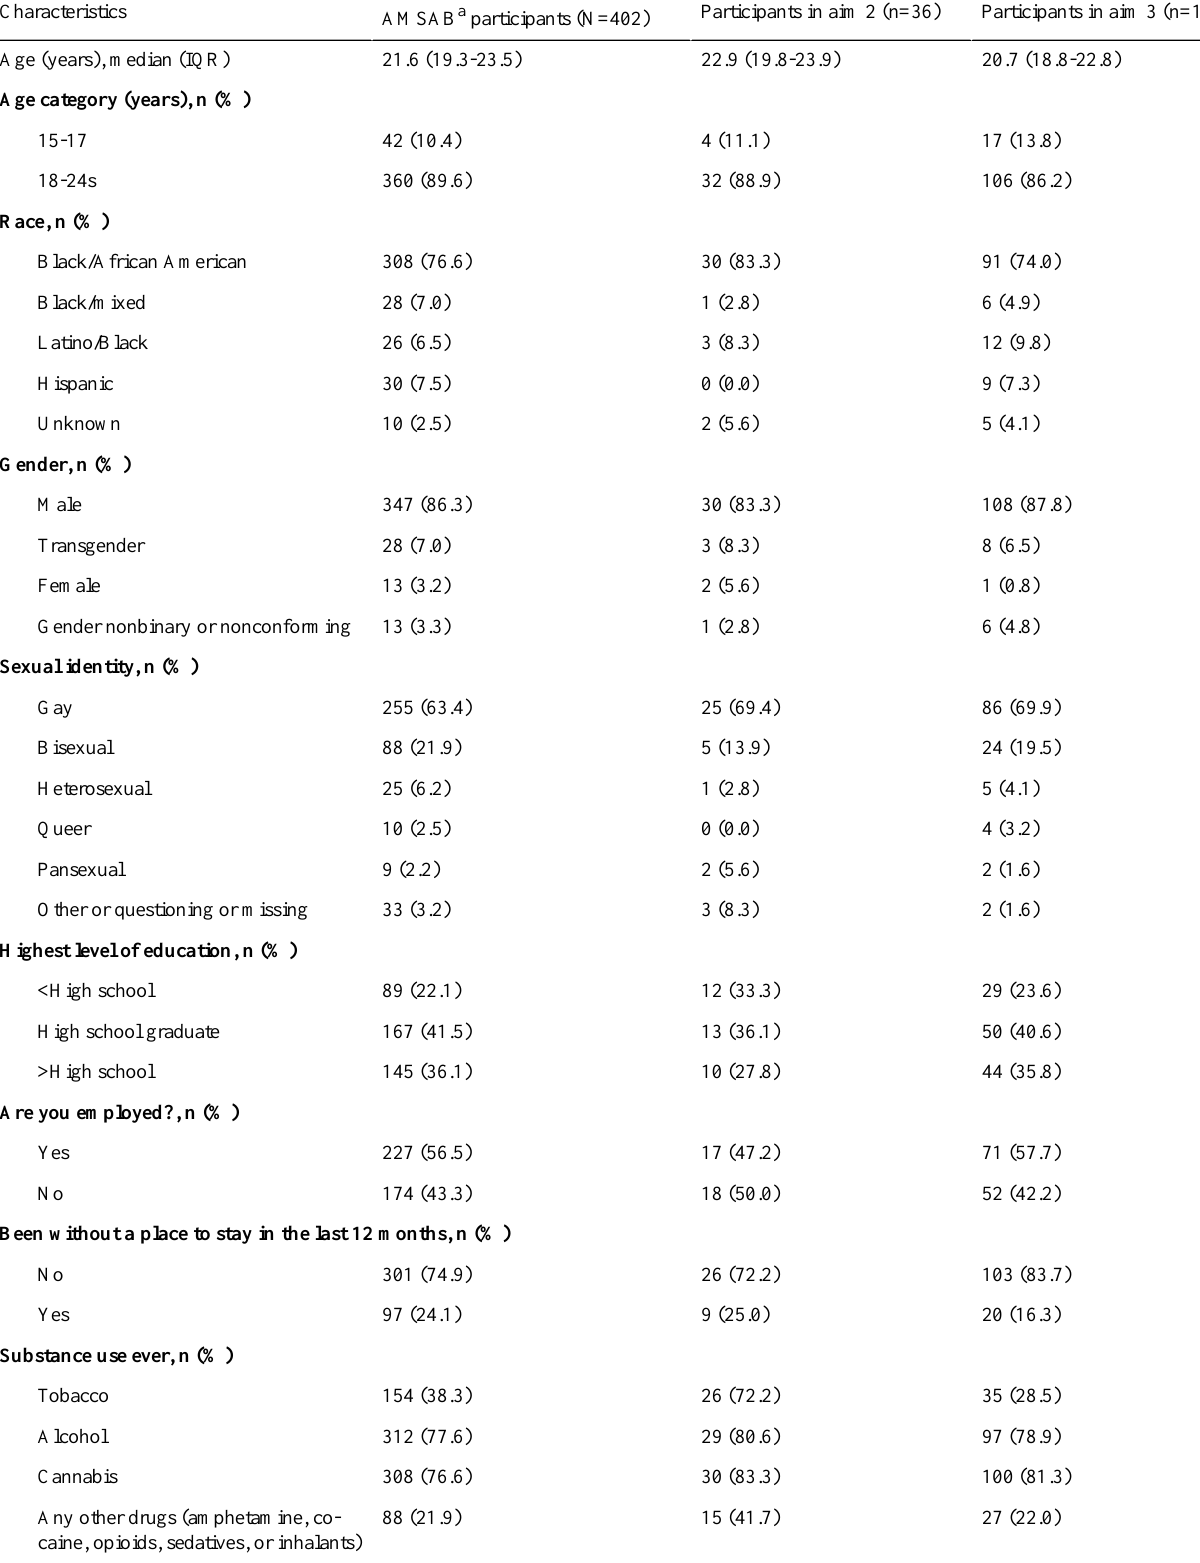
Table 3. Demographic characteristics and substance use at baseline for